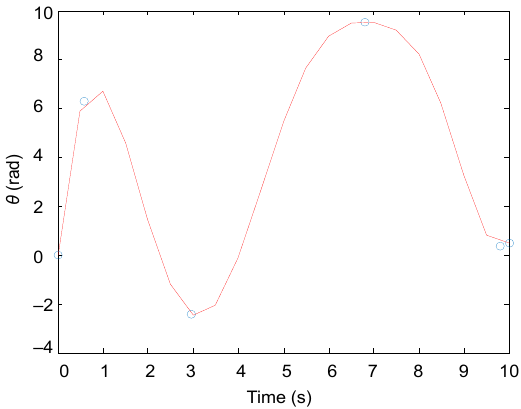
Figure 14. Displacement curve produced by the cubic Hermite interpolation.